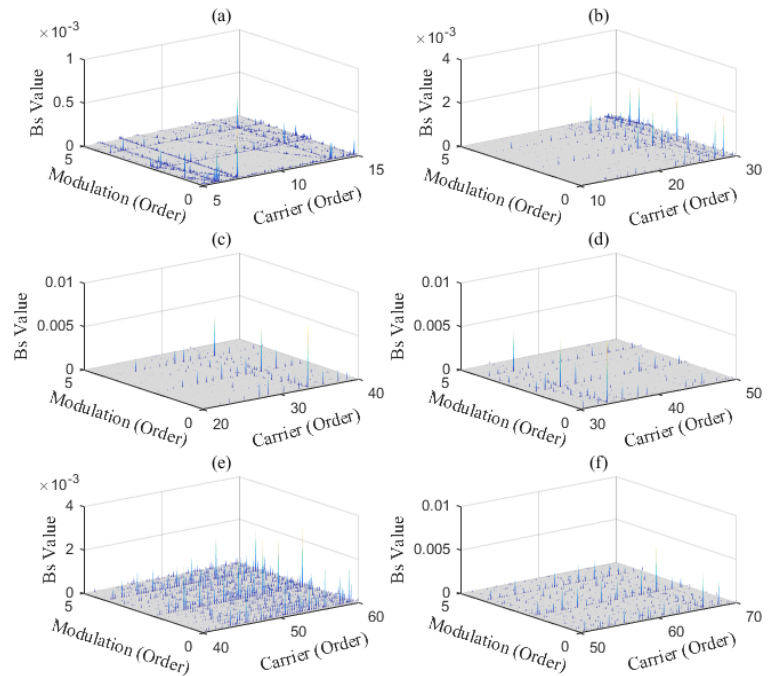
Figure 9. The OB values distribution under different carrier frequency ranges: ( a ) From 5 Order to 15 Order; ( b ) From 10 Order to 30 Order; ( c ) From 20 Order to 40 Order; ( d ) From 30 Order to 50 Order; ( e ) From 40 Order to 60 Order; ( f ) From 50 Order to 70 Order.